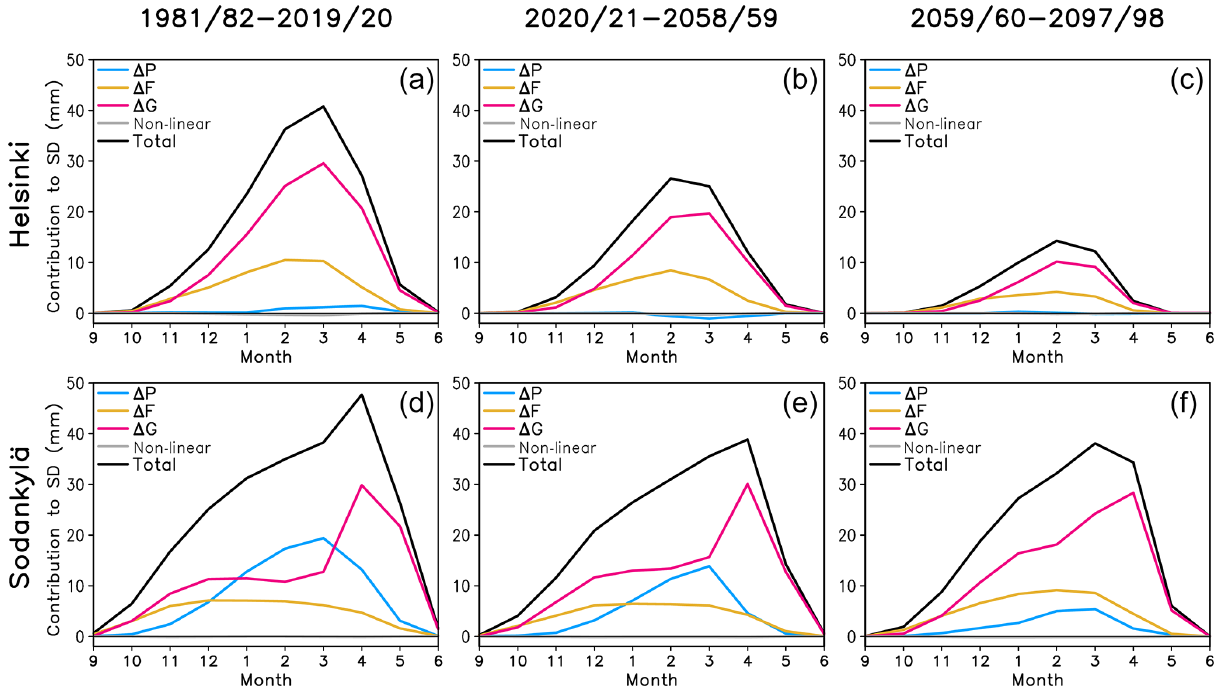
Figure 12. Multi-RCM mean interannual standard deviation of SWE (black line) in Helsinki (a–c) and Sodankylä (d–f) in the periods 1981/82–2019/20 (a, d) , 2020/21–2058/59 (b, e) and 2059/60–2097/98 (c, f) and the contributions of the four rhs terms in Eq. (2) to it (coloured